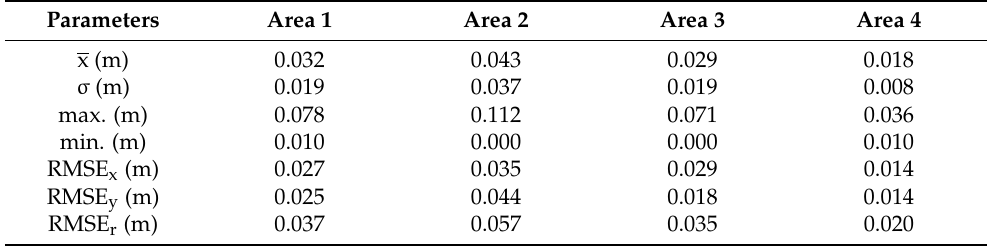
Table 3. Result of the statistical parameters of planimetric validations of orthophotomosaics.